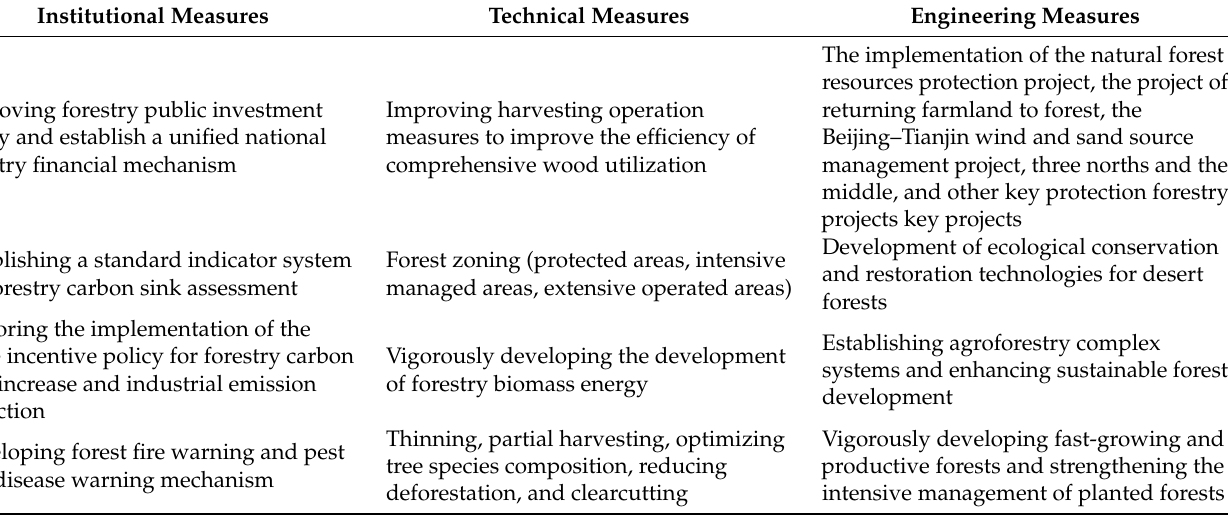
Table 4. Adaptive management measures for climate change in forestry